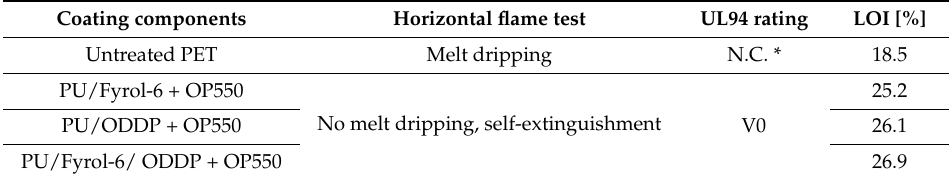
Table 4. Coating composition and flame retardant (FR) performances of PET fabrics treated with waterborne polyurethane (PU)-FR coatings